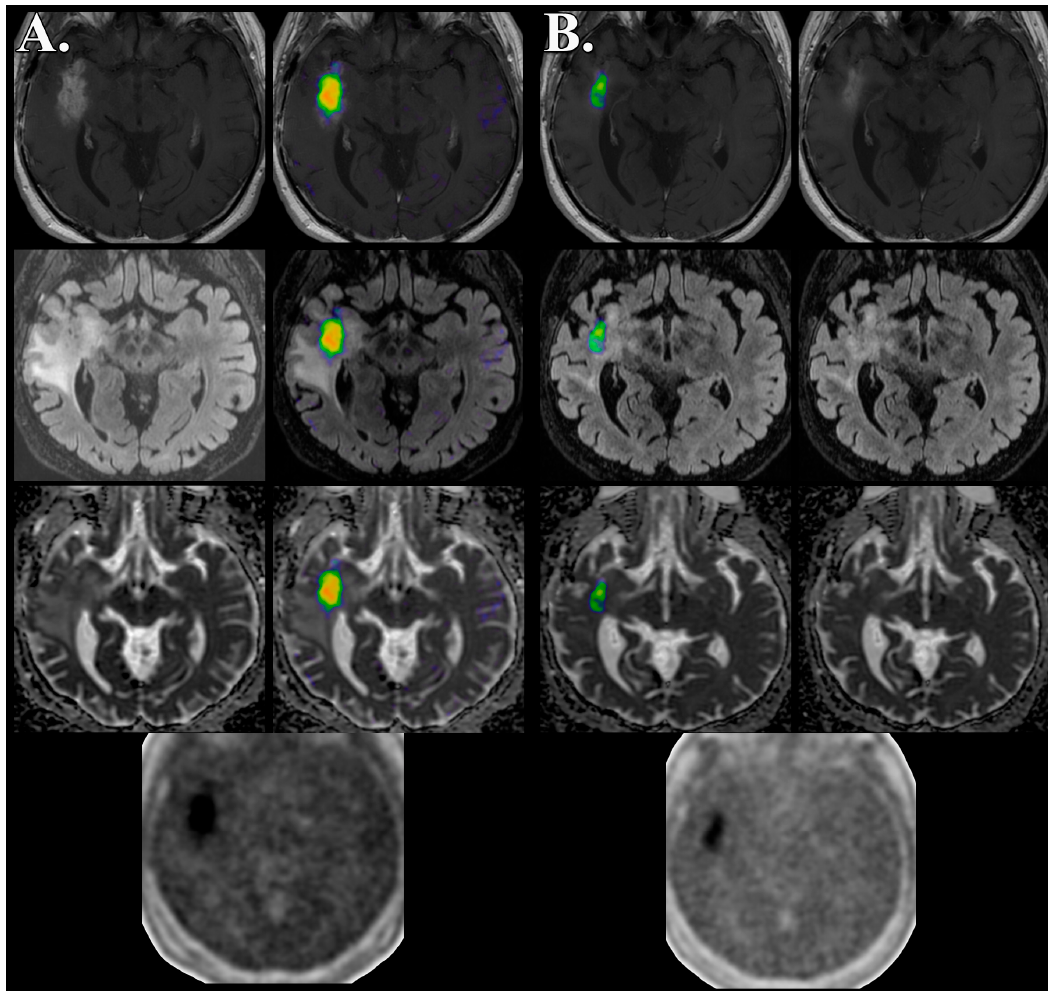
Figure 3. Decreased but persistent FMISO hypoxic volume in recurrent high grade glioma concurrent with bevacizumab therapy. FMISO PET/MR imaging obtained simultaneously 7 days prior to ( A ) and 36 days following antiangiogenesis therapy ( B ) demonstrates response to therapy characterized by decreased volume of contrast enhancement (top row) and nonenhancing FLAIR hyperintense mass (middle row) without evidence of reduced diffusion (adc map, bottom row). Unprocessed (bottom) and fused FMISO PET imaging (baseline, middle left; follow-up, middle right) demonstrates decreased but persistent tumor hypoxic volume predominately within the enhancing component. Follow-up